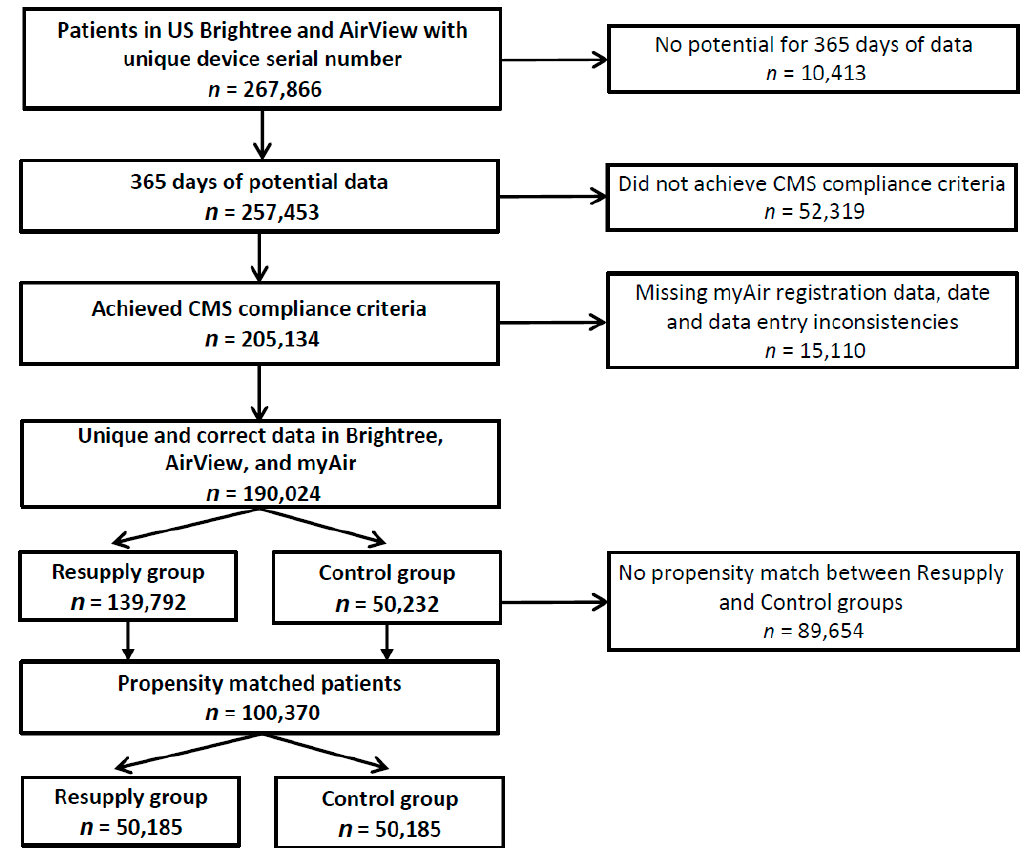
Figure 1. Flow diagram. CMS, Centers for Medicare and Medicaid.